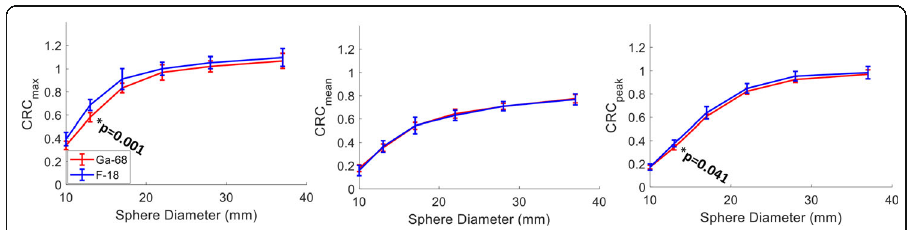
Fig. 4 Average CRC max (left), CRC mean (middle) and CRC peak (right) for all 6 Gallium-68 (blue curve) and the 12 Fluorine-18 (red curve) acquisitions reconstructed with standard OSEM. The error bars represent the standard deviation between sites. Significant difference was noticed for the 13-mm sphere at the 5% significance level for CRC max and CRC